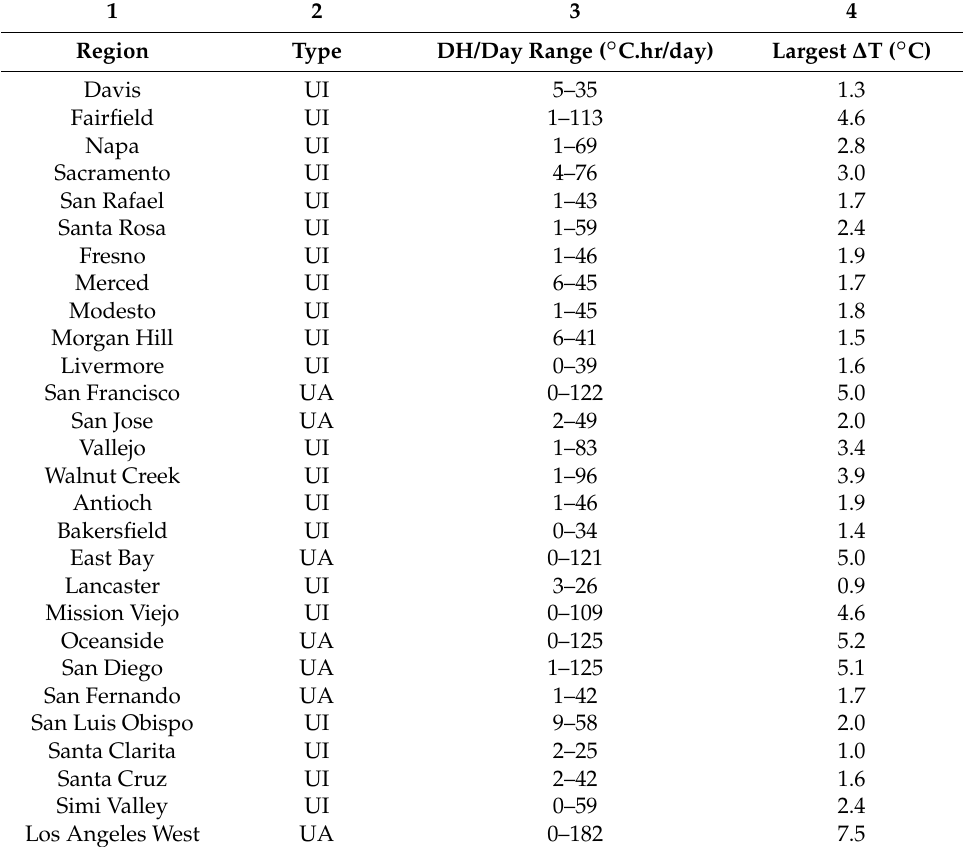
Table 1. UHII range for a sample of urban areas in California. The full tabulation for all 40 urban areas is provided in Taha and Freed, 2015